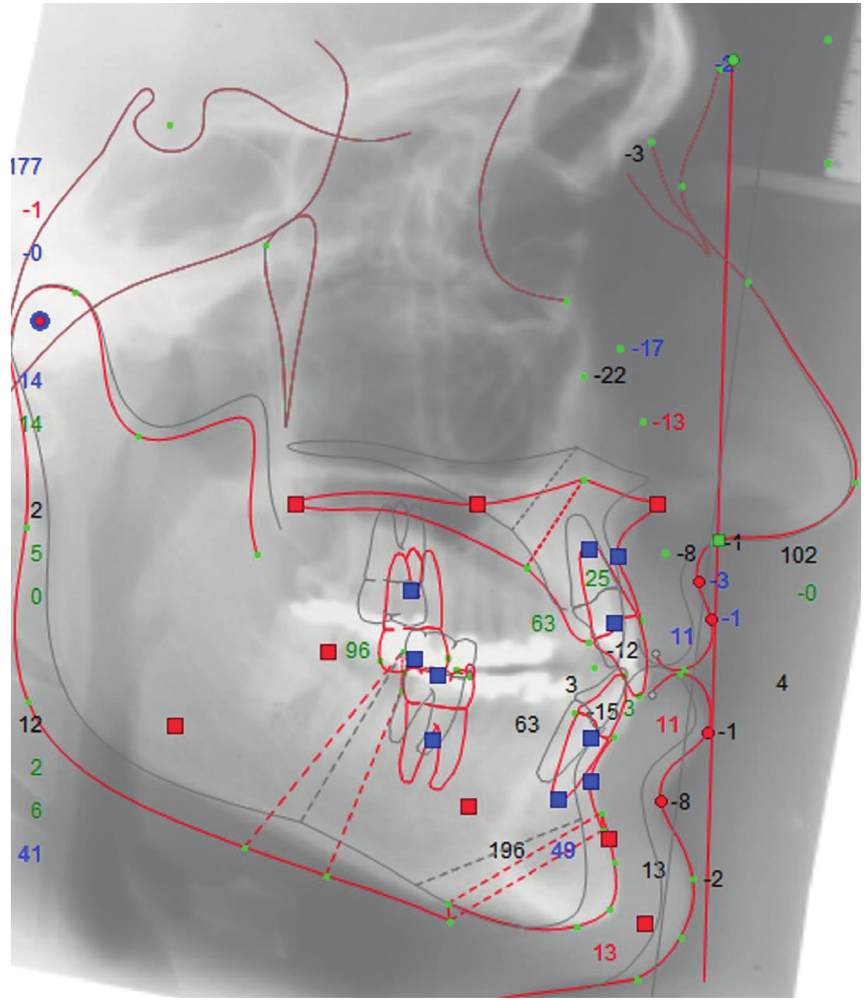
Figure 1: Digital predictive tracing simulating orthognathic